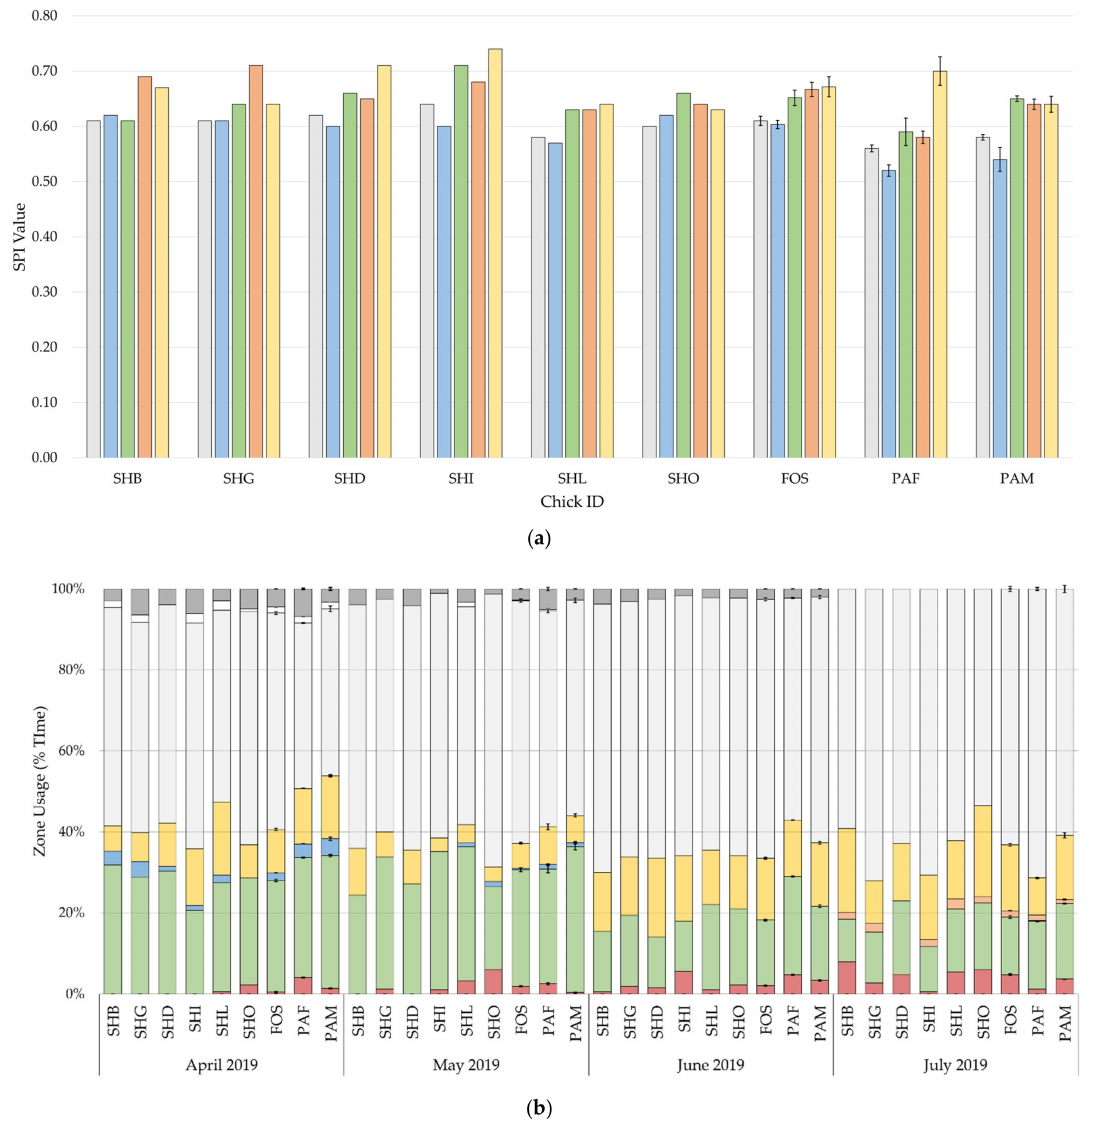
Figure 4. ( a ) Overall and monthly Spread of Participation Index (SPI) for individual foster-reared chicks, foster-reared chicks as a group (FOS), and grouped female and male parent-reared chicks (PAF and PAM, respectively). Grey = overall; blue = April; green = May; yellow = June; orange = July. Standard error bars represent variation within parent-reared chicks. ( b ) Average monthly time-zone usage budgets of individual foster-reared chicks, grouped foster-reared chicks (FOS), and grouped female and male parent-reared chicks (PAF and PAM, respectively). Dark grey = shelter; white = public viewing area’s; light grey = nesting area; yellow = mid-waters; orange = island; blue = front water; green = back grasslands; red = bushland. Standard error bars represent variation within parent-reared chicks. Chicks spent most time in the nesting area. Over time, occupancy in the nesting area increased, and occupancy in the middle-water and shelter area decreased. Foster-reared chicks occupied the nesting area more than parent-reared chicks, overall average of 60% and 55%,